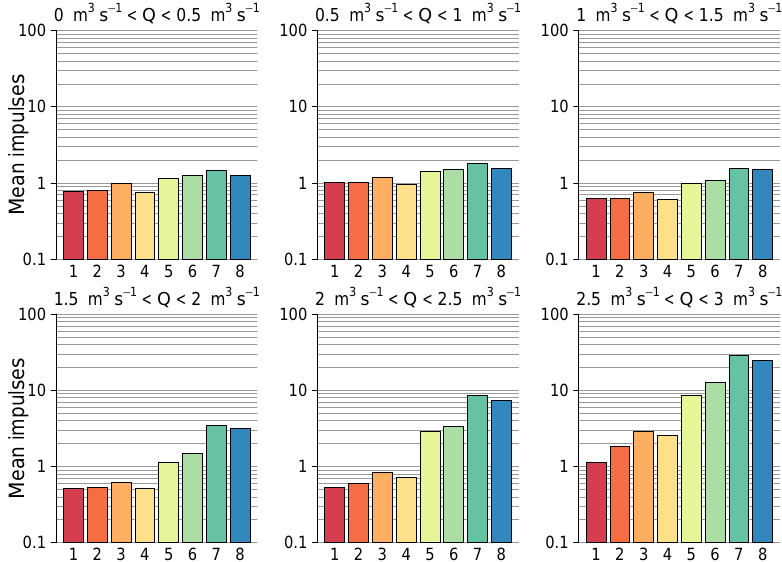
Figure 14. Ruetz: arithmetic mean of geophone impulses per 15min for each of the eight plates (ordinates), averaged over the period 2008–2013 and including zero values, for discharge Q classes with width of 0.5m 3 s − 1 , for discharges up to 3m 3 s − 1